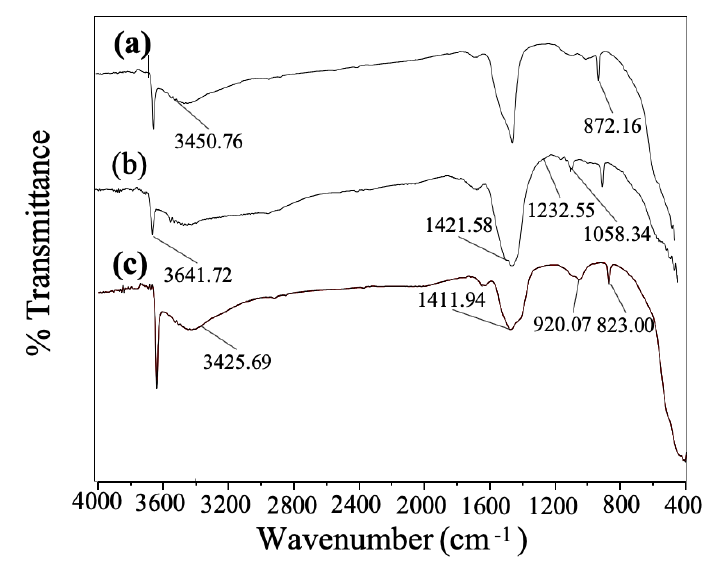
Figure 2. FT-IR spectra of ( a ) KOH-CaO, ( b ) KOH-impregnated eggshell, and ( c ) eggshell calcined at 800 °C for 5 h. Table 1. Chemical composition (wt%) of eggshell and KOH-impregnated eggshell . Material